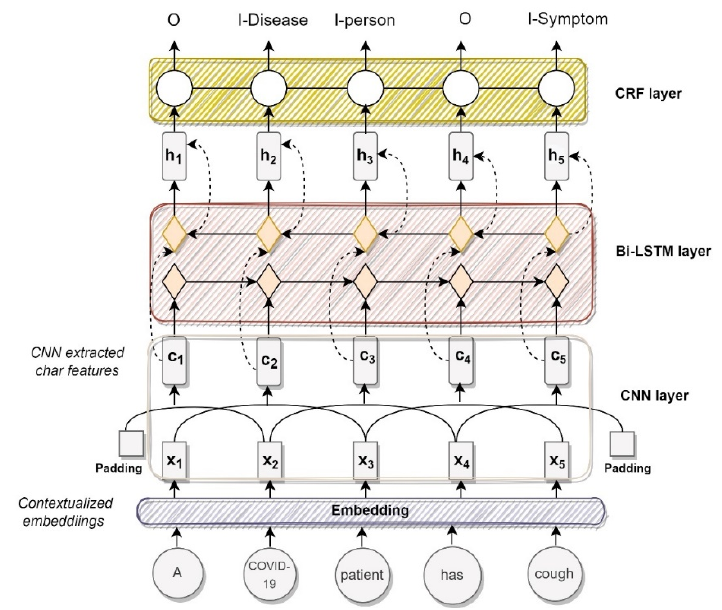
Figure 2. Named Entity Recognition algorithm.